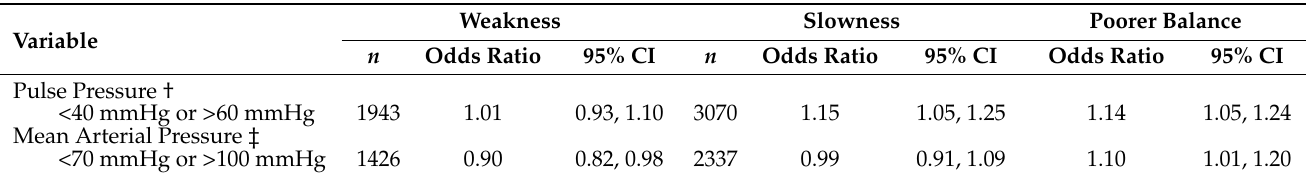
Table 3. Associations of the Combined Pulse Pressure and Mean Arterial Pressure Groups on Physical Function.